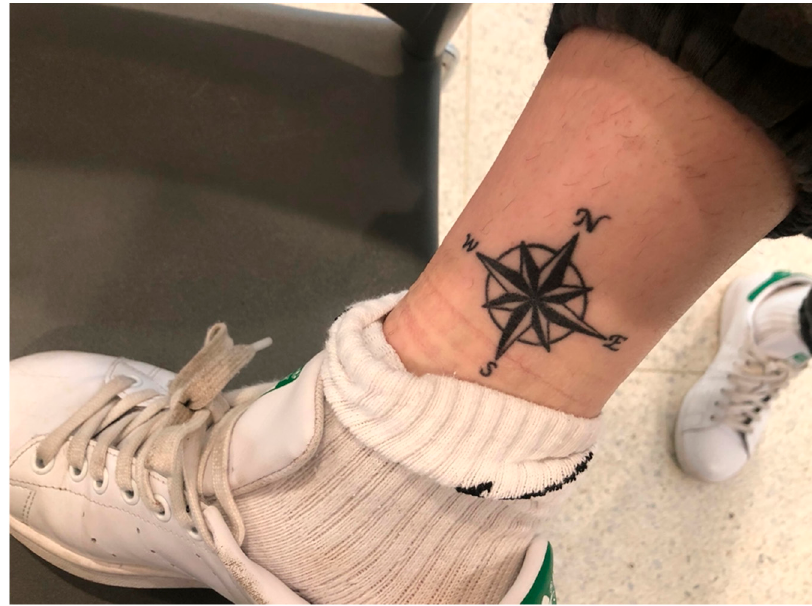
Figure 1. Rowan’s compass tattoo on her right ankle.